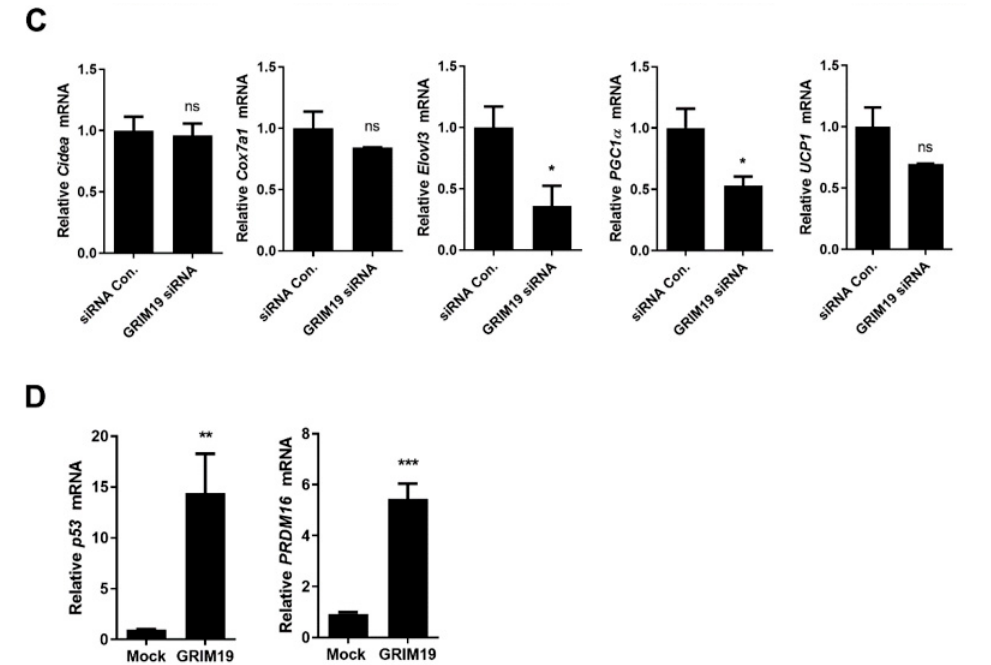
Figure 2. GRIM19 regulates BAT differentiation. ( A ) Representative images of Oil Red O-stained C2C12 cells. Mock, GRIM19-overexpressing, control siRNA (siRNA Con), or GRIM19 siRNA C2C12 cells were stained with Oil Red O. Scale bar, 100 µ m. The bar graph shows averaged percentage of Oil Red O-stained area. ( B ) Transcript levels of cell death-inducing DNA fragmentation factor alpha-like effector A ( Cidea ), cytochrome C oxidase polypeptide 7A1 (Cox7a1) , fatty acid elongase 3 ( Elovl3 ), PGC1a , and UCP1 in mock-vector (MOCK) and GRIM19-overexpressing C2C12 cells. ( C ) Transcript levels of Cidea , Cox7a1 , Elovl3 , PGC1a , and UCP1 in control and GRIM19-depleted C2C12 cells. ( D ) Transcript levels of p53 and PRDM16 in mock-vector and GRIM19-overexpressing C2C12 cells. GAPDH was used as the internal control. Data are presented as the means ± SDs of three independent experiments. * p < 0.05, ** p < 0.01, *** p < 0.001, ns = not significant.